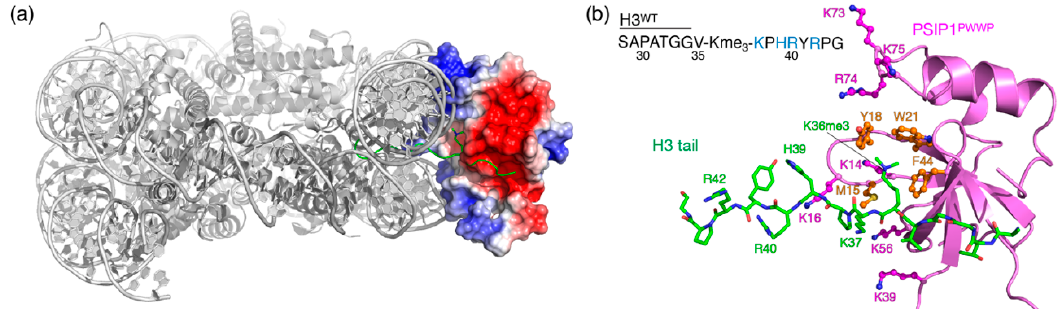
Figure 1. The synergetic nature of PSIP1 PWWP binding to nucleosomes. ( a ) Structure of PSIP1 PWWP bound to nucleosomes with trimethylated H3 tail residue K36 (H3K36me3), illustrating the electrostatic interactions of positively charged surface residues on the PWWP domain with both gyres of nucleosomal DNA [36,38]. The H3 tail is shown in green. ( b ) Details of the PSIP1-H3 tail interaction, with the aromatic cage (orange) and DNA binding (magenta) residues shown as sticks. The native H3 tail peptide (H3 WT ) sequence is annotated with positively d charged residues highlighted.